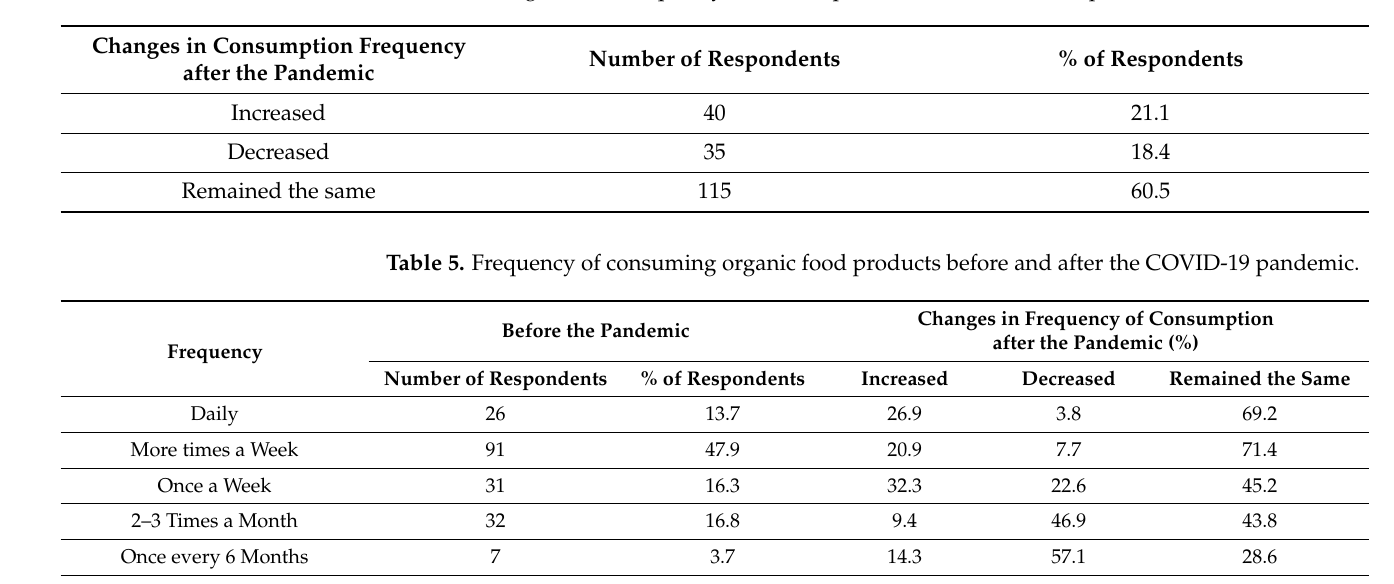
Table 4. Changes in the frequency of consumption after the COVID-19 pandemic.